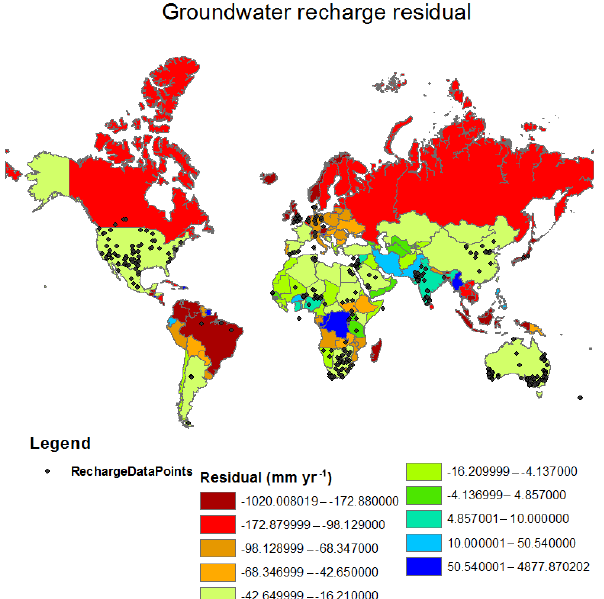
Figure 12. Spatial distribution of groundwater recharge residual (FAO estimates less model estimates) along with recharge sites se- lected for model